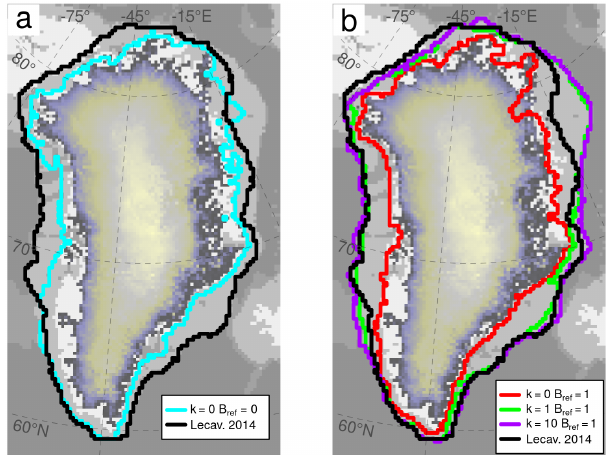
Figure 13. Modelled minus observed surface elevation for the present day. Modelled data are taken from the GRISLI-UCM sim- ulation which best estimates the presumed LGM extension ( B ref = 1ma − 1 and κ = 10ma − 1 K − 1 ) while the observed surface eleva- tion is taken from Bamber et al. (2013). Purple and black lines rep- resent simulated and observed GrIS extensions, respectively. Black circles indicate the locations of the Camp Century, NEEM, NGRIP, GRIP and Dye3 ice cores (from north to